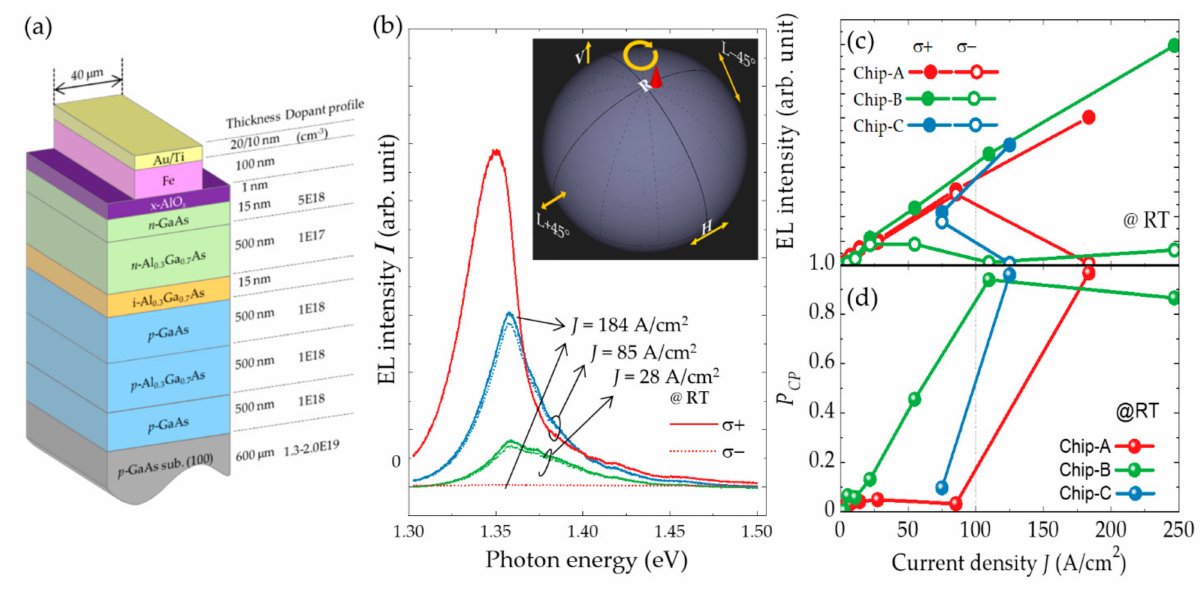
Figure 3. ( a ) Schematic structure of spin-LED for high DOCP with the layer thicknesses and doping profiles. ( b ) Helicity- dependent EL spectra at RT corresponding to three current densities: J = 28 (dotted curve), 85 (dashed curve), and 184 (solid curve) A/cm 2 . The red and blue curves show the σ + and σ − EL components, respectively. Inset depicts the polarization state of the data with J = 184 A/cm 2 on Poincar é sphere measured by a calibrated polarimeter. Plots of the ( c ) integrated intensity of σ + (closed symbols) and σ − (open symbols) EL components and ( d ) C PC as a function of J for three different spin-LED chips. Reproduced with permission from